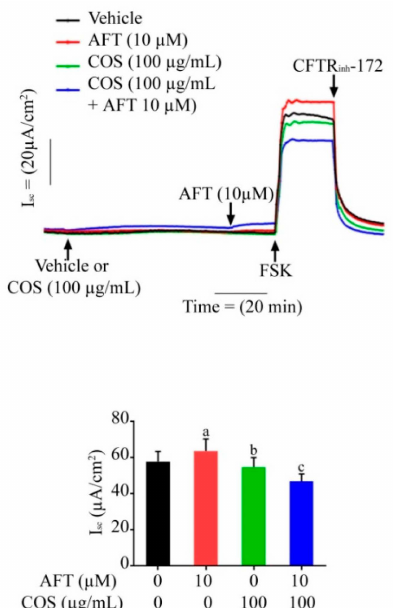
Figure 2. Effect of afatinib and COS on barrier junction. ( Cotreatment ) T84 cell monolayers were treated with the indicated concentrations of reagents for 24 h. ( Pre-treatment ) Cells was pre-incubated with COS for 4 h followed by incubation with afatinib. Data are expressed as means of FITC-dextran concentration ± SD. ( n = 5; **** p < 0.0001; one-way ANOVA).